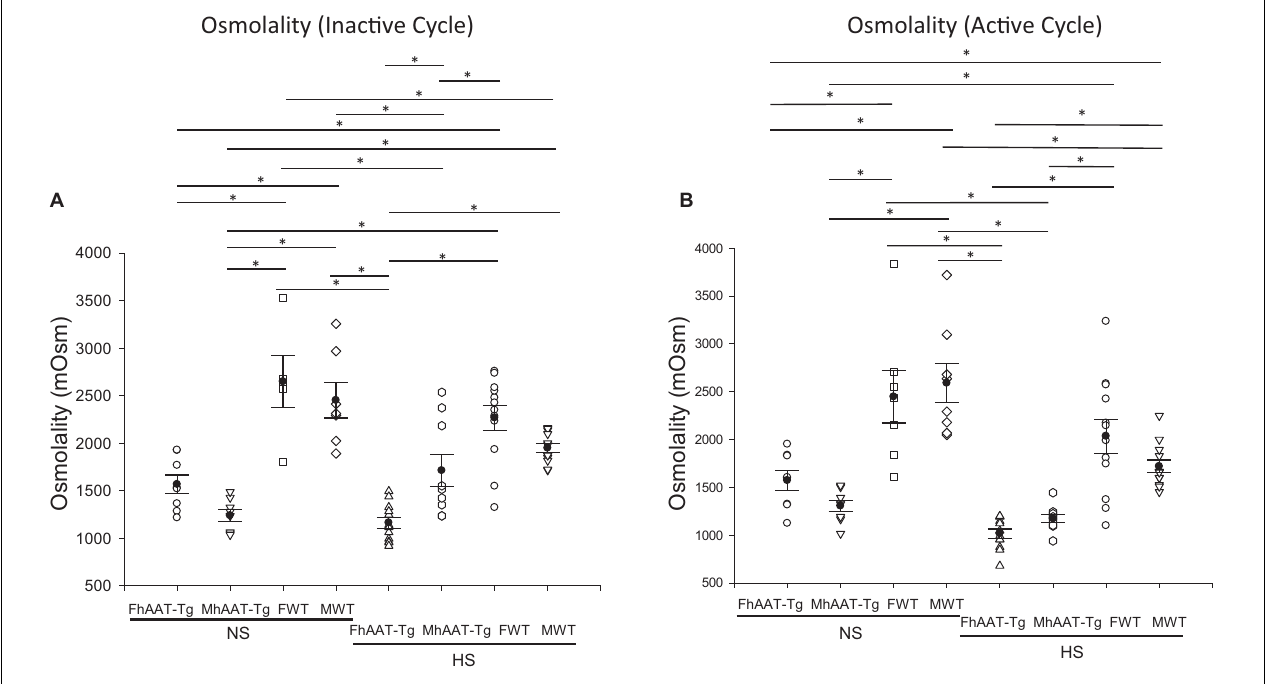
FIGURE 2 | Urine osmolality for male and female hAAT-Tg and C57B/6 wild-type mice maintained on a normal or high salt diet during the inactive and active cycles. (A) Urinary osmolality during the inactive cycle for female and male hAAT-Tg mice and C57B/6 wild-type mice maintained on a normal salt (NS) or high salt (HS) diet. (B) Urinary osmolality during the active cycle for female and male hAAT-Tg mice and C57B/6 wild-type mice maintained on a normal salt (NS) or high salt (HS) diet. N = 7 hAAT-Tg (4 female and 3 male) and N = 8 C57B/6 (4 female and 4 male) mice. These results were analyzed using a One-Way ANOVA followed by a Holm-Sidak comparison. We used a significance level of * p < 0.05.